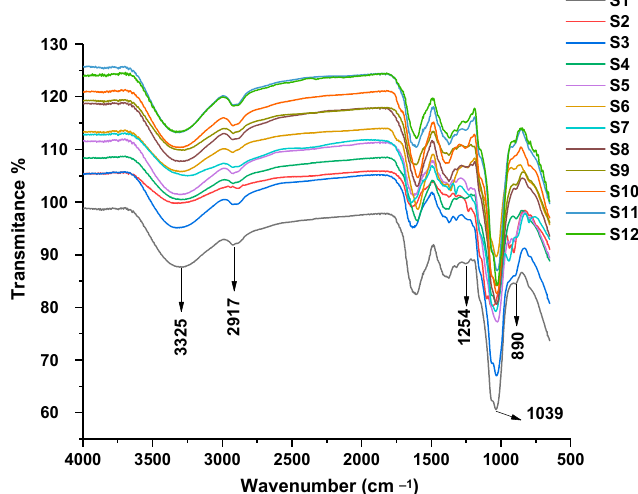
Figure 1. FTIR spectra of Ganoderma lucidum polysaccharides.